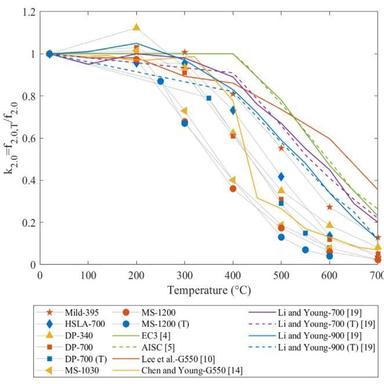
Comparison of 2.0% yield stress (transient-state test results are marked with 'T').